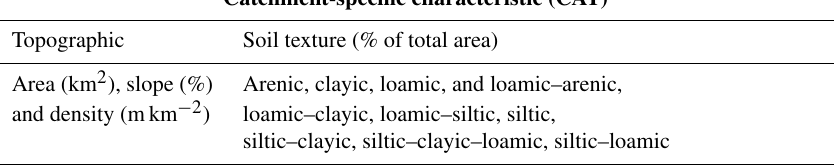
Catchment-specific characteristic